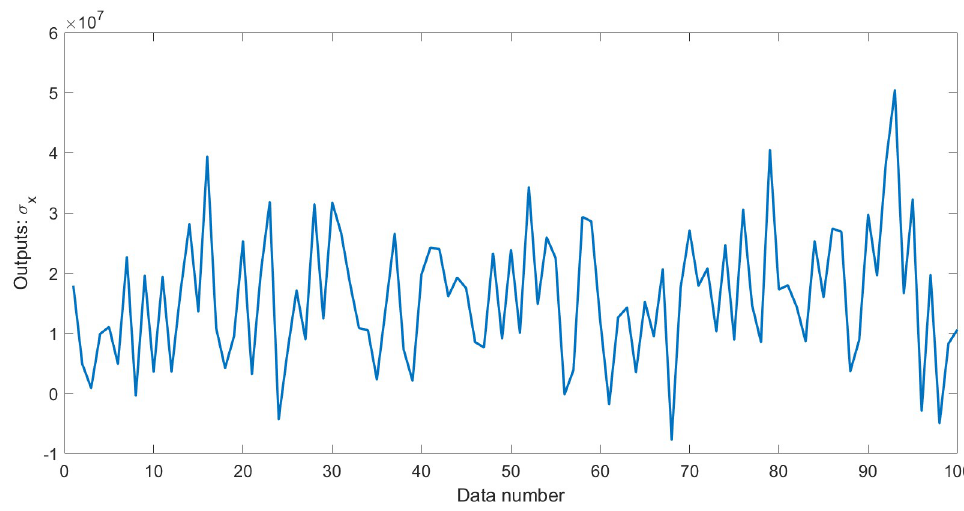
Fig 14. Outputs σ x with errors in dataset 4.